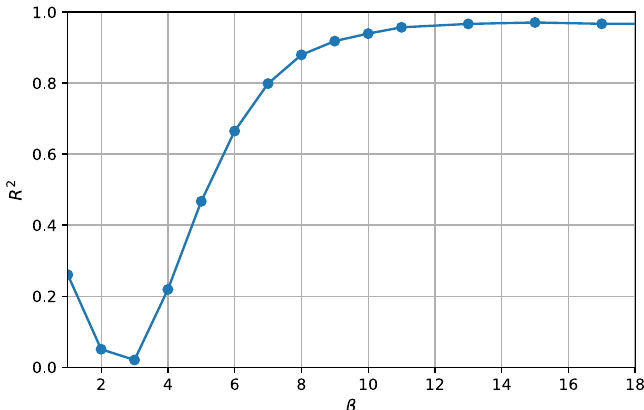
Fig. 8 WGCNA parameter. In WGCNA, a coefficient of determination R 2 larger than 0.8 indicates that the network is approximately scale-free, making β = 8 a good choice for our